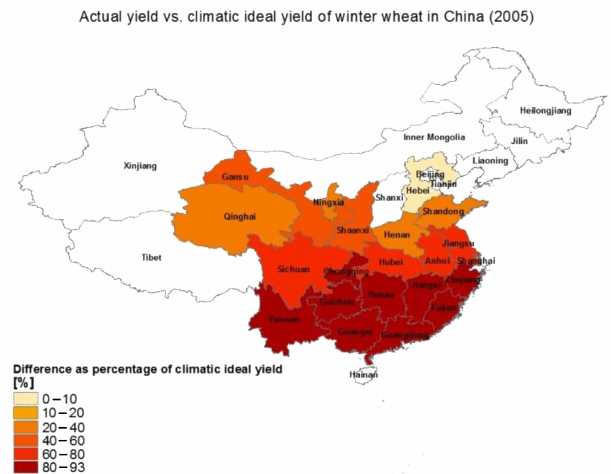
Figure 7. Differences between actual provincial yields of winter wheat in China in 2005 (NBSC, 2013) and simulated yields from the current study (assuming no crop stress except for water stress in rain-fed areas), expressed as percentage of the simulated yield.